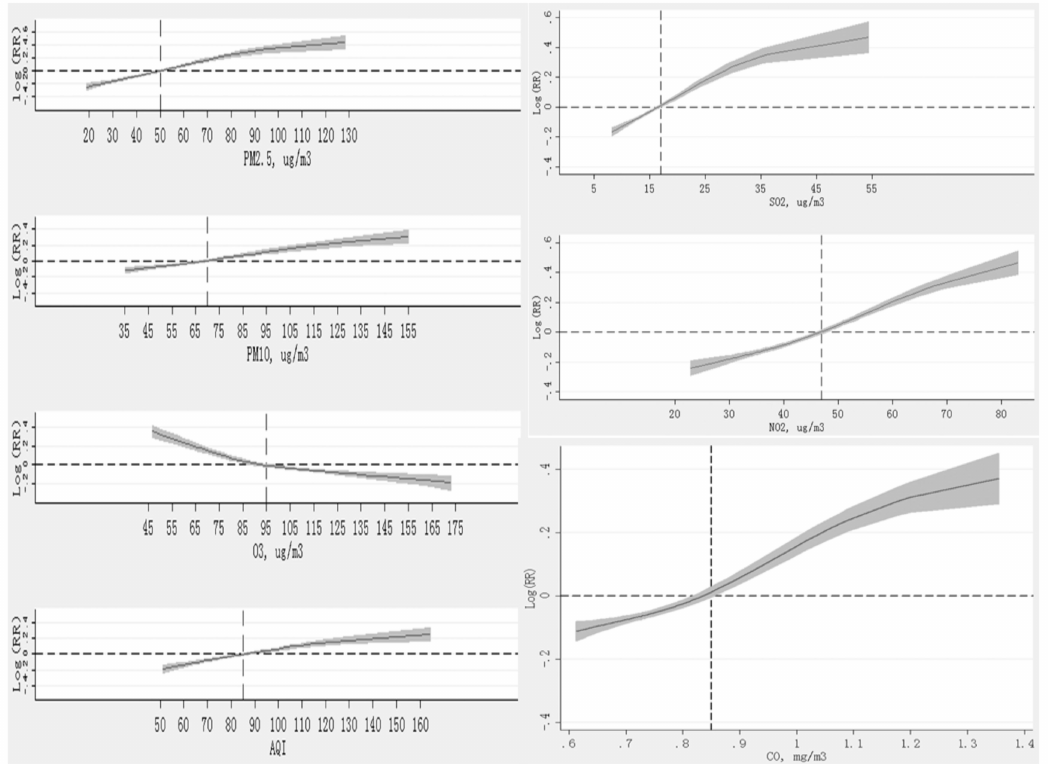
Figure 2. The non-linear relationships between concentrations of PM 2.5 , PM 10 , SO 2 , NO 2 , CO, O 3 , andAQIandtheriskoftuberculosisaftercontrollingforseasonalityandlong-termtrends. Thesolidlines indicate the estimated log relative risk of tuberculosis and the dashed lines indicate the corresponding 95% confidence